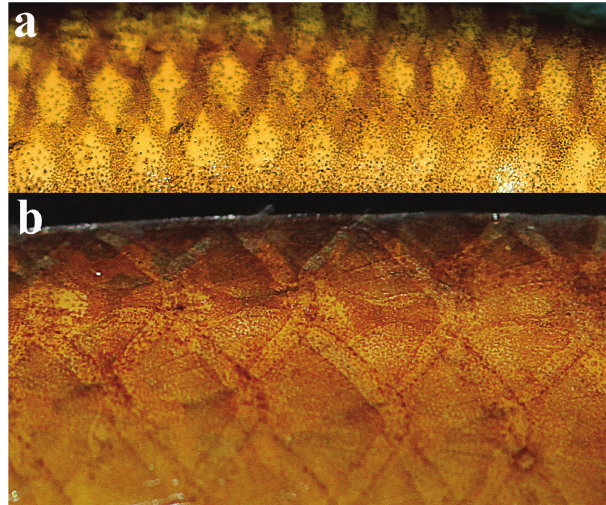
Fig. 5. Detailed images of the dorsolateral series of scales in Deuterodon pedri , showing their pigmentation pattern, each scale showing an arched and well delineated strip at the distal margin of the free border that is either dark brown when chromatophores are expanded ( a. MNRJ 38463, 51.18 mm SL) or translucent when chromatophores are contracted ( b. MCN 19698, 85.70 mm